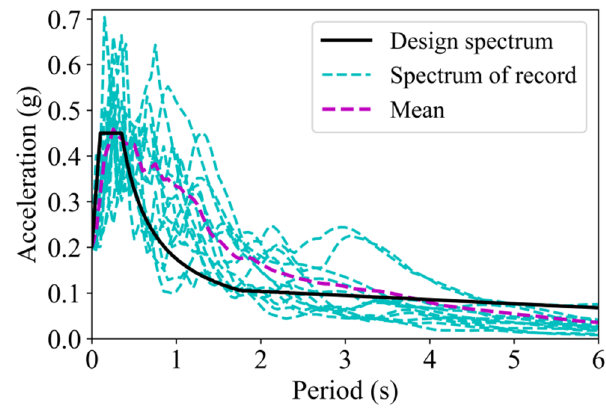
Figure 3. Mean spectrum of earthquake records.